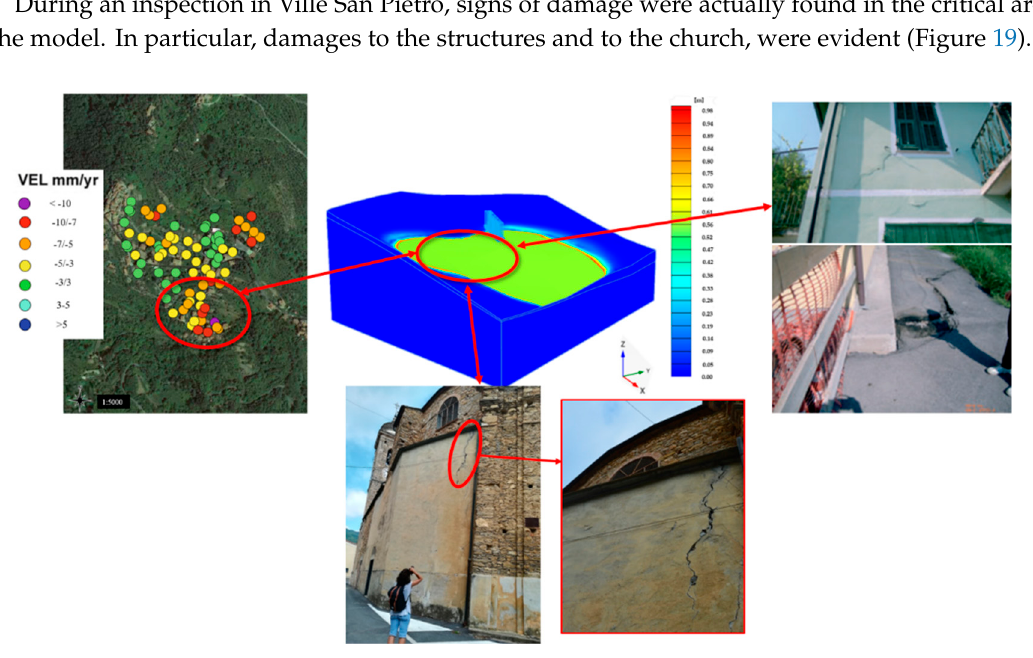
Figure 20. Model validation referred to the lower part of Ville San Pietro.